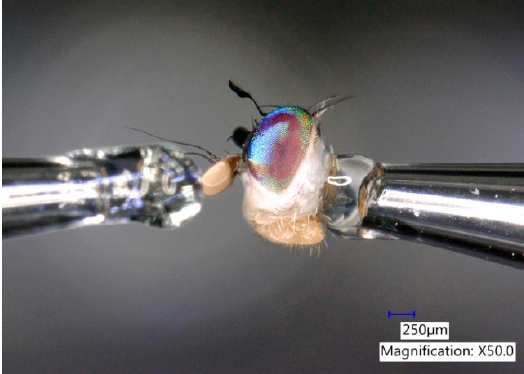
Figure 5. A dissected medfly head mounted with antennae extended between electroantennography (EAG) electrodes. Photo credit: Teresa Narvaez (USDA-ARS, SHRS).